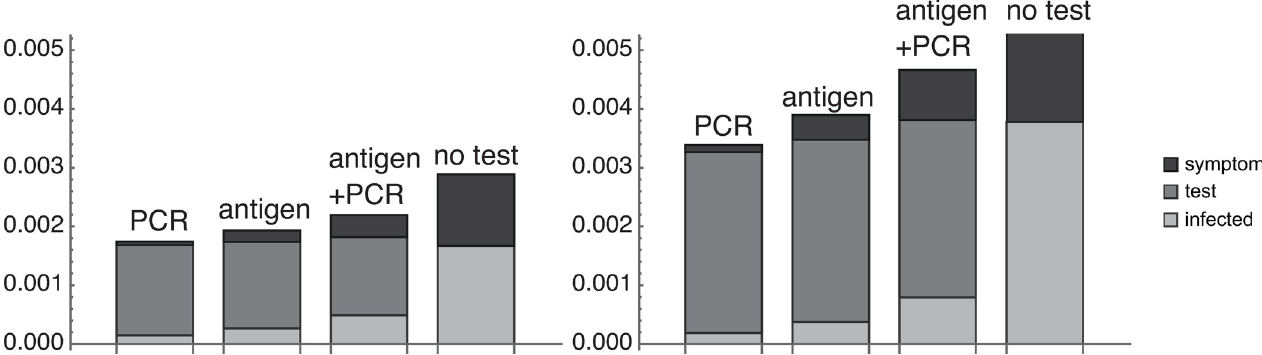
Fig 6. Number of infected and quarantined individuals. Number of infected individuals playing in the games (in Fig 5) plus the number of individuals quarantined from the group owing to infection. Black shows the number quarantined by checking for symptom, dark gray shows the number quarantined by routine testing, and light gray is the number in Fig 5 (number of infected individuals participating in the games). In the left panel, the probability that there is an infected individual at arrival ( p ) is 1.0 × 10 − 4 , and in the right panel the probability is 1.0 × 10 − 3 p